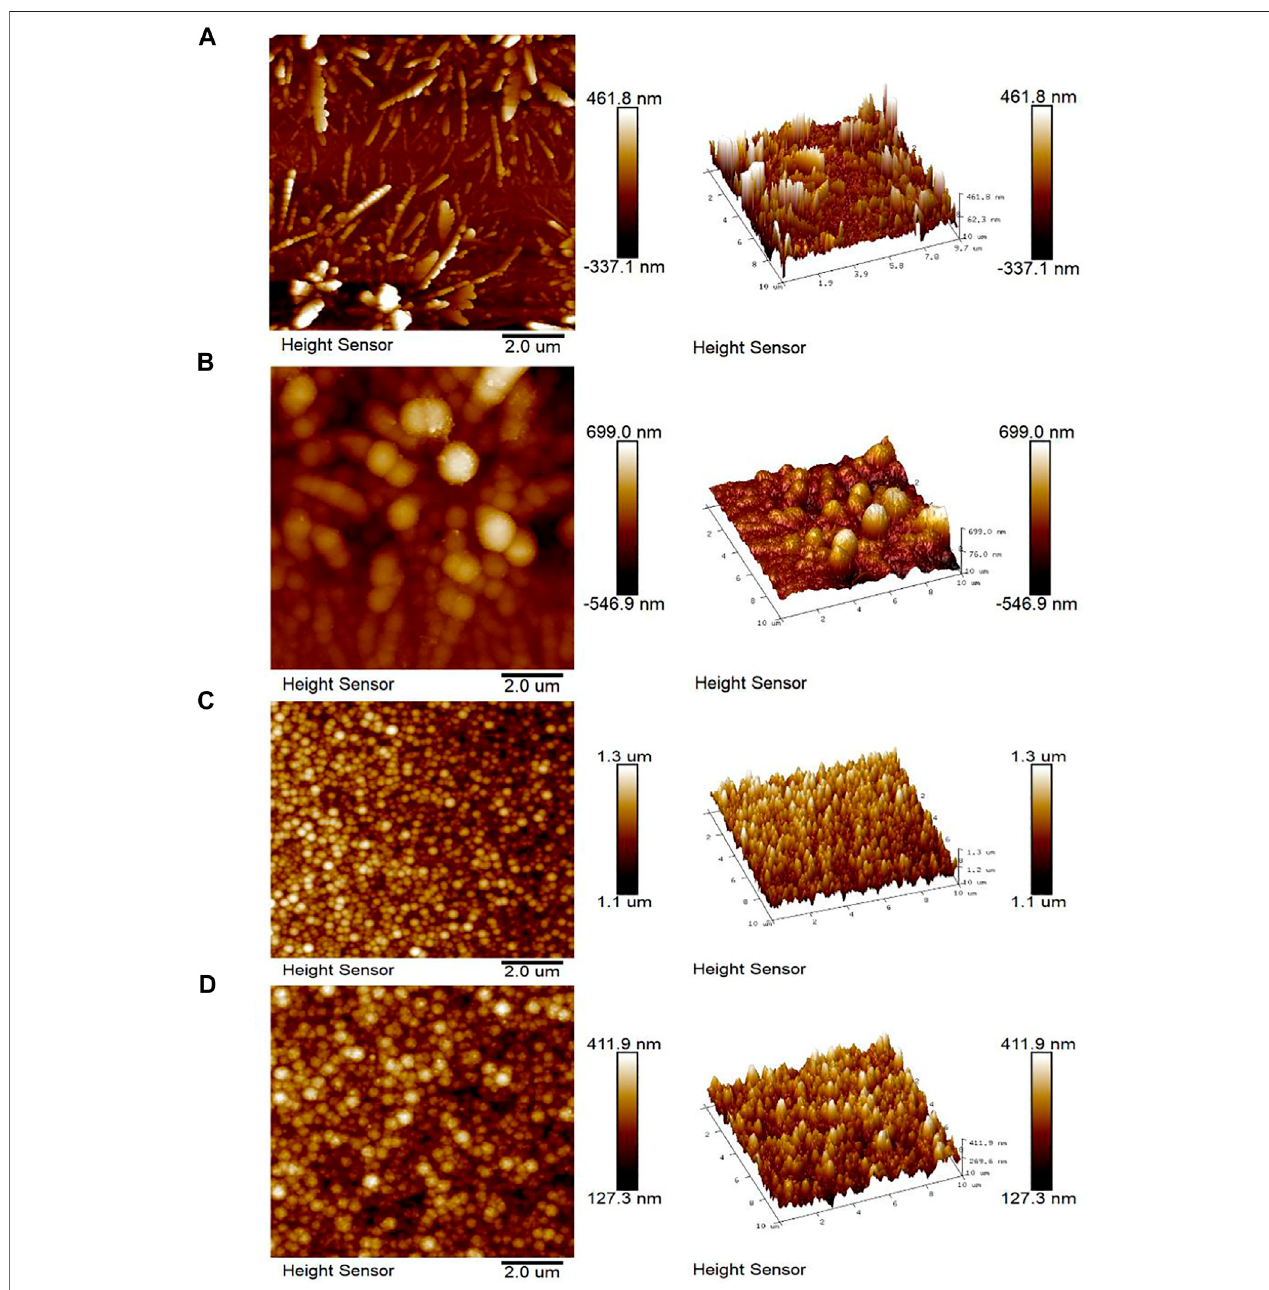
FIGURE 4 | AFM diagrams of the (A) Mo/Cu, (B) Mo/Cu/Sb, (C) Mo/Sb, and (D) Mo/Sb/Cu layers.